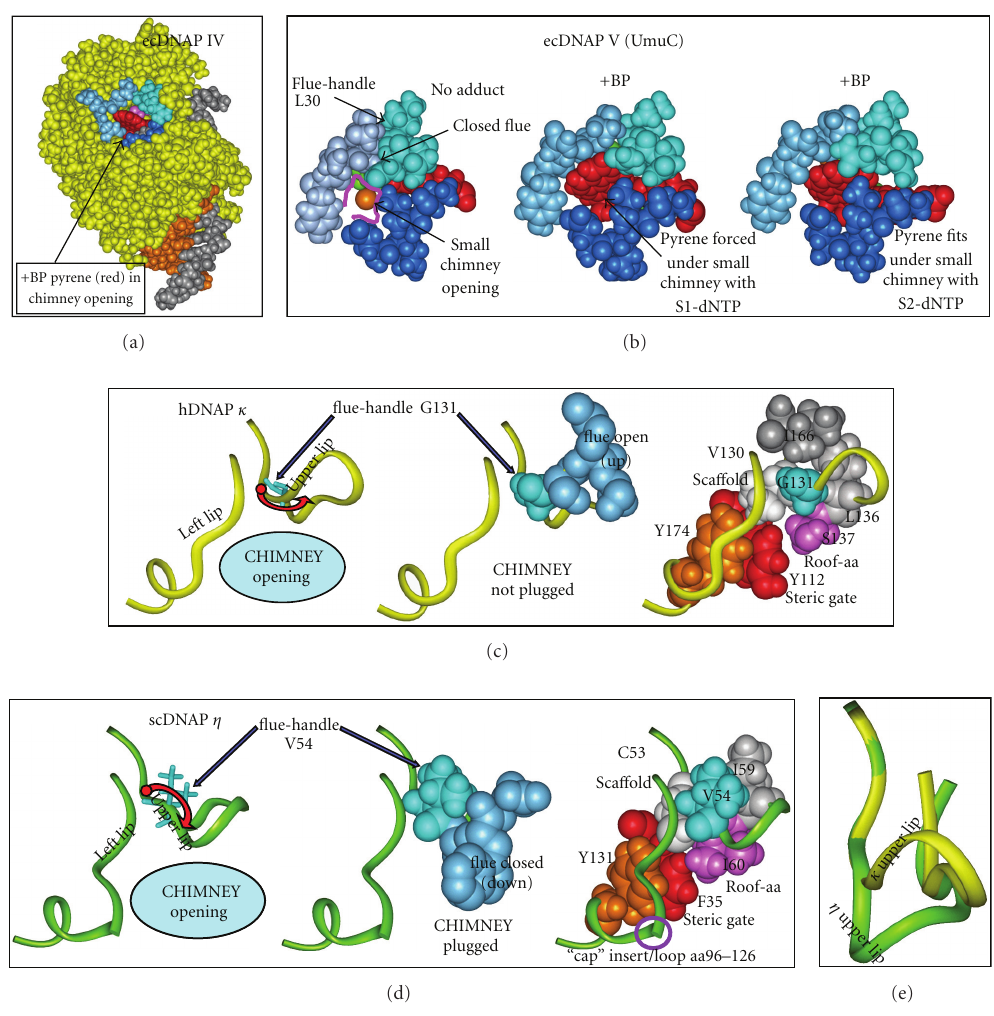
Figure 3: Structures of regions of ecDNAP IV (a), ecUmuC(V) (b), hDNAP κ (c), scDNAP η (d). (a) View from the minor groove side of DNAP IV (yellow), showing the “chimney” opening (cleft or hole), which is defined by the upper lip (turquoise, aa33–36), left lip (blue, aa73–76) and lower lip (dark blue, aa244–247). The chimney opening in DNAP IV is large enough to accommodate the pyrene moiety of +BP (red). In DNAP IV, the dG moiety of +BP can base pair comfortably with dCTP in the canonical S1-dNTP shape. (Neither the dG moiety of +BP nor the dCTP are visible.) The template (gray) and primer (brown) are also shown. (b) Models of UmuC(V) with no adduct (B/left) or +BP paired with dCTP in the canonical “chair-like” S1-dNTP shape (b/center) or +BP paired with dCTP in the non- canonical, “goat-tail-like” S2-dNTP shape (b/right). The chimney opening is small (b/left) and the pyrene moiety of +BP does not fit into the chimney such that the S1-dNTP shape is possible (b/center). In contrast, the pyrene moiety of +BP fits under the chimney opening in the case of pairing with dCTP in the S2-dCTP shape (b/right), because it sits lower down in the active site compared to S1-dNTP. (c) Regions of hDNAP κ . Y-Family DNAPs in the IV/ κ -class have a glycine “flue-handle,” such as G131 (turquoise, c/left) in hDNAP κ G131 adopts φ/ϕ -angles that lead to upward curvature of the protein backbone in the chimney upper lip (red arrow, c/left) and results in the “flue” amino acids (S132/M133, blue, c/center) pointing away from the chimney, giving a large opening. The c/right structure shows V130 (white) that serves as a sca ff old to organize the chimney’s upper lip and left lip (yellow ribbons), along with the roof-aa (S137, purple), the steric gate (Y112, red) and a conserved tyrosine (Y174, brown), which stacks on the backbone of the left lip and helps orient it. V130 forms a square with the G131 flue-handle, L136 (gray) and the S137 roof (pink) upon which I166 stacks (dark gray). (d) Regions in scDNAP η. Y-Family DNAPs in the V/ η class have a bulky “flue-handle,” such as V54 in scDNAP η (turquoise, d/left), which causes downward curvature of the chimney upper lip (red arrow, d/center), and results in the “flue” amino acids (Q33/W34, blue, d/center) plugging the chimney, giving a small opening. The structure in d/right shows sca ff old C53 (white) organizing the chimney’s upper lip and left lip (green ribbons in (c)), along with the roof-aa (I60, purple), the steric gate (F35, red) and a conserved tyrosine (Y131, brown), which stacks on the backbone of the left lip and orients it. C53 forms a square with the V54 flue-handle (turquoise), I59 (gray) and the I60 roof (pink). scDNAP η has a large insert/loop (aa96–126) in the left lip, which is represented as a discontinuity. (e) The upper lip for hDNAP κ (yellow) is superimposed on the upper lip for scDNAP η (green), which clearly shows the di ff erences in curvature. X-ray coordinates are from 2OH2 for hDNAP κ [29] and from 1JIH for scDNAP η [27], where hydrogens were added using